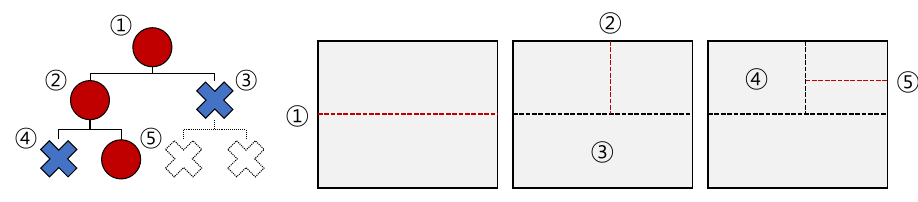
Figure 6. Example of generating an image collage frame with recursive partitioning with L = 2. In this example, the partitioning occurs in the node notated in the red circle ( ① , ② , and ⑤ ) while the others do not. In this example, the partition axis for ① , ② , and ⑤ are horizontal, vertical, and horizontal, respectively. For each partition level, the partitioning would not occur when it is in the maximum level of partition (after ⑤ ) or the decision of partition occurrence is false (in ③ ).